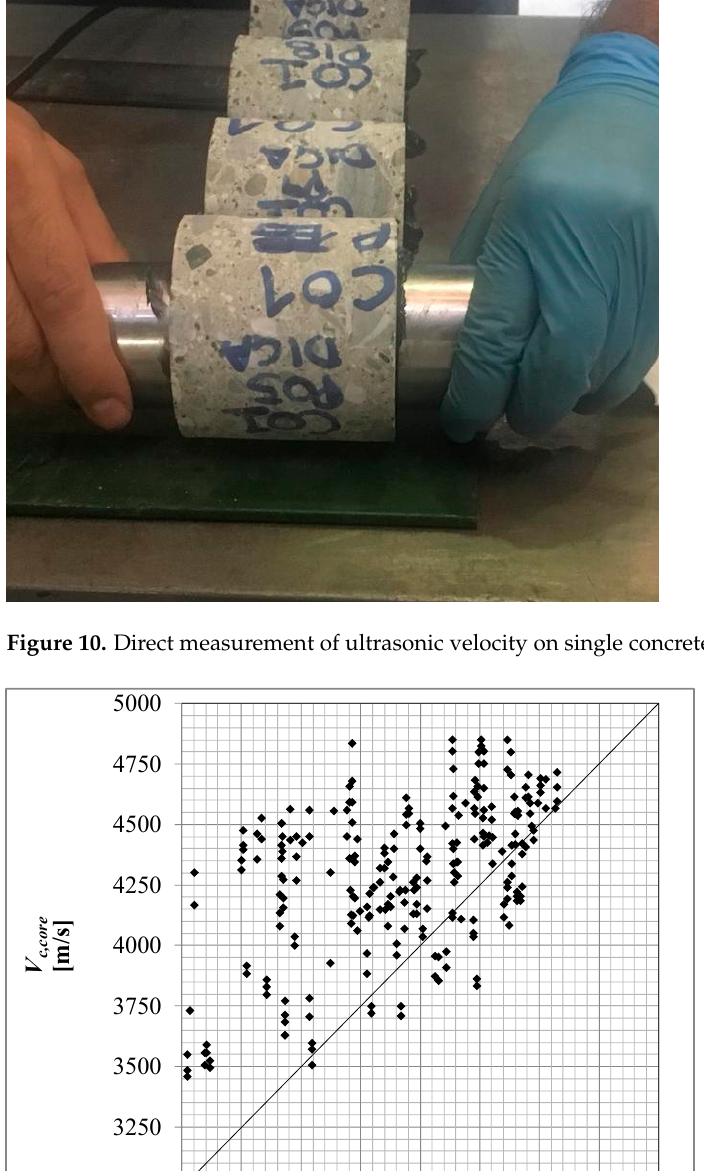
Figure 11. In situ direct ultrasonic velocity ( V c,insitu ) test vs. ultrasonic velocity test samples ( V c,core ).